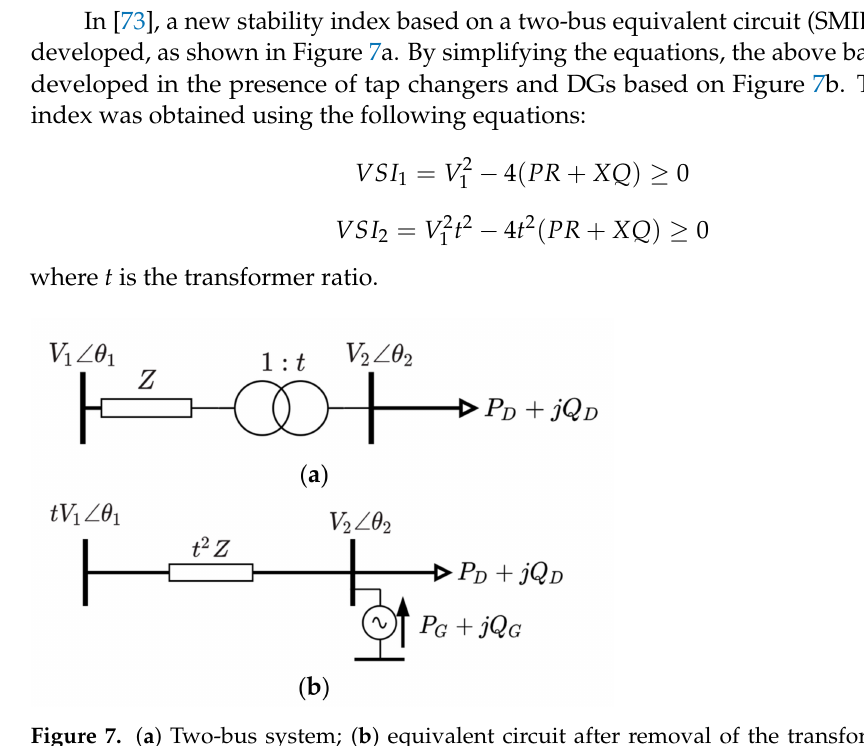
Figure 7. ( a ) Two-bus system; ( b ) equivalent circuit after removal of the transformer (elements transferred from the primary side to the secondary side) in the presence of tap chargers and